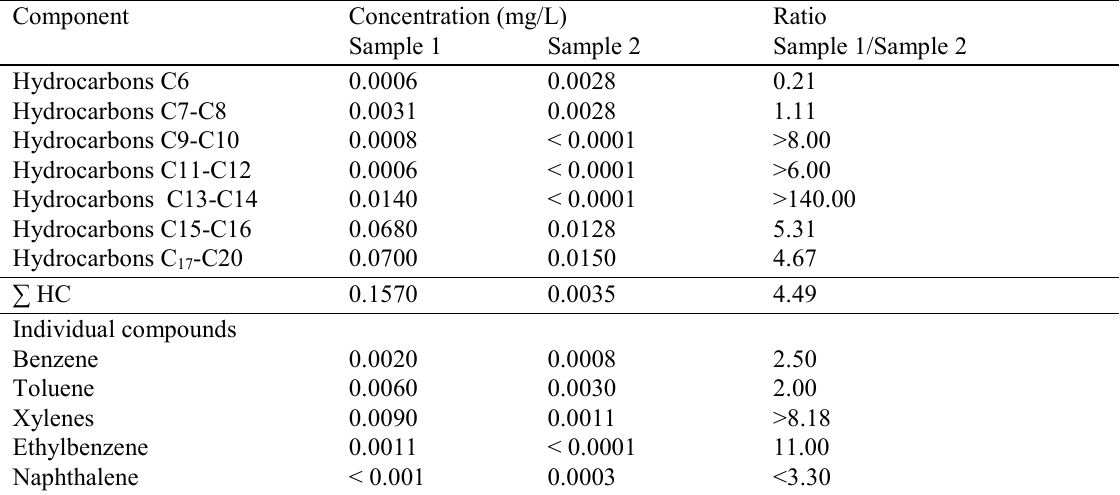
Table 1 Content of some oil components in water samples of a migrating spot for sampling at various distances (Pechora River, August 1997).